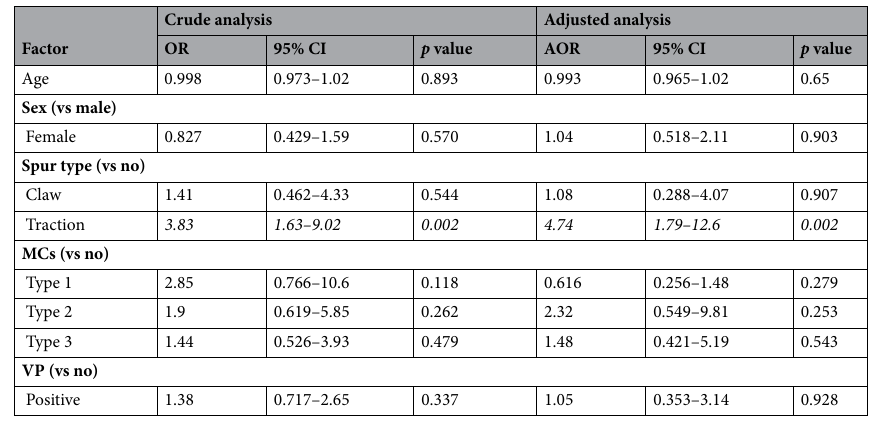
Table 5. Associations of traction spur, Modic changes, vacuum phenomenon with prevalence of ST > 2 mm. The crude analysis used single-variate logistic regressions whereas the adjusted analysis used multivariate logistic regression including all explanatory variables. ST, sagittal translation; MCs, Modic changes; VP, vacuum phenomenon; OR, odds ratio; AOR, adjusted odds ratio. Significant values are in italics.